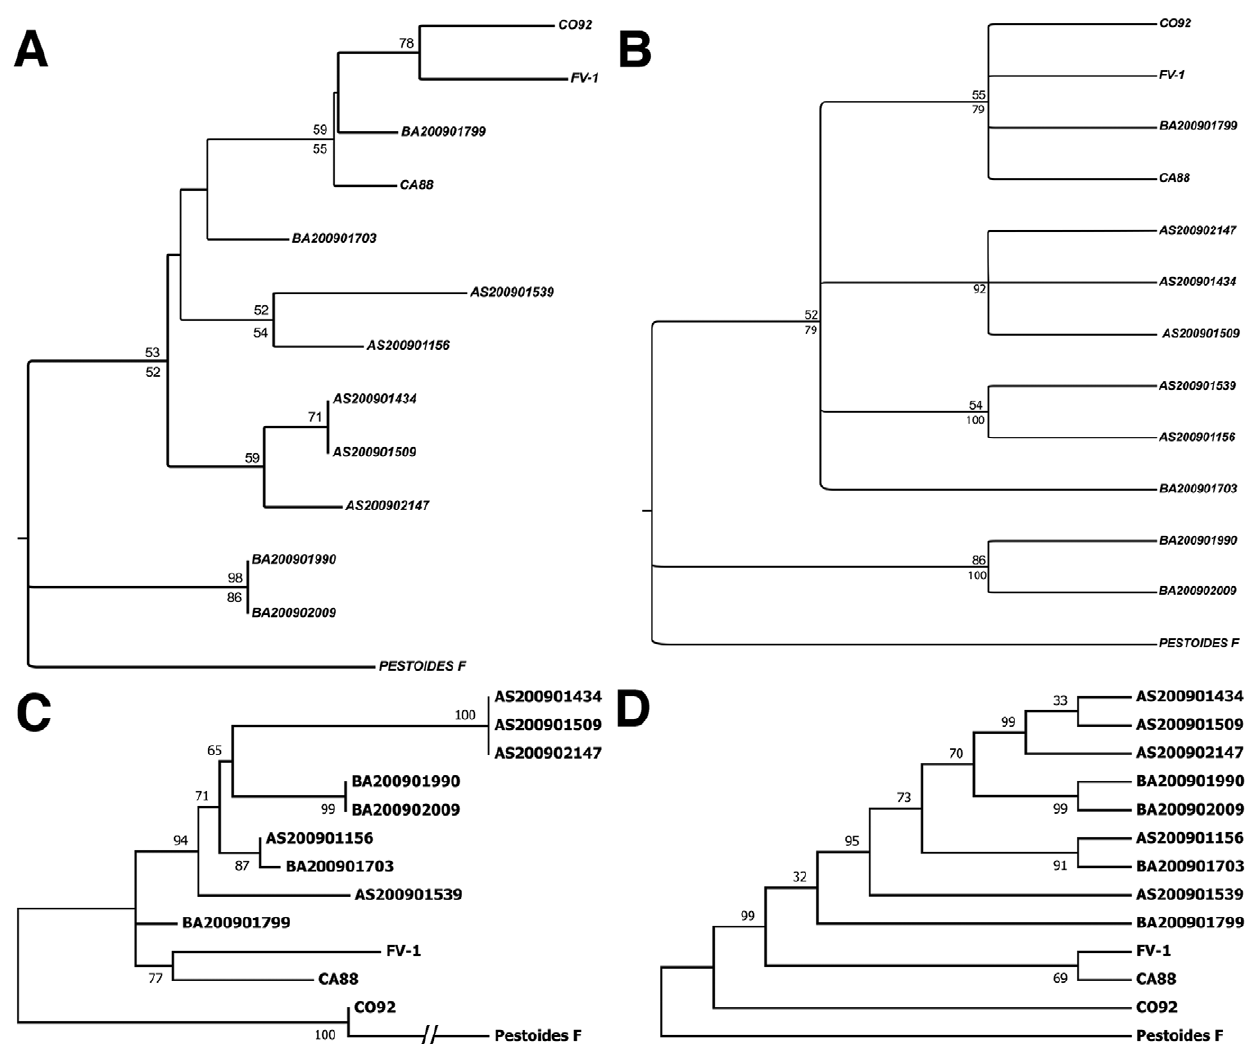
Figure 3. Phylogenetic Analysis of 2009 Plague Isolates. The phylogenies of the 2009 isolates were inferred from MLVA data (Panels A and B) or the SNP/Indel data (panels C and D). In all cases, the Pestoides F strain was utilized as an outgroup. Panels A and B : Reconstruction of relationships from MLVA data. ( A ) Neighbor Joining Analysis of MLVA data. Numbers above branches represent NJ analysis bootstrap proportions, greater than 50%, based on 1000 replications; numbers below branches represent MP analysis bootstrap support. ( B ) Maximum Parsimony analysis. Numbers above branches represent bootstrap proportions, greater than 50%, based on 1000 replications; numbers below branches represent Majority Rule consensus values. Panels C and D : Phylogenetic analysis using newly identified SNPs/Indels using the ( C ) Maximum Likelihood method. The tree with the highest log likelihood ( 2 411.0996) is shown. The percentage of trees in which the associated taxa clustered together is shown next to the branches. ( D ) Phylogenetic analysis using the Maximum Parsimony method. The percentage of replicate trees in which the associated taxa clustered together in the bootstrap test (1000 replicates) are shown next to the branches. Additional details for the methods employed in phylogenetic reconstructions can be found in Materials and Methods.